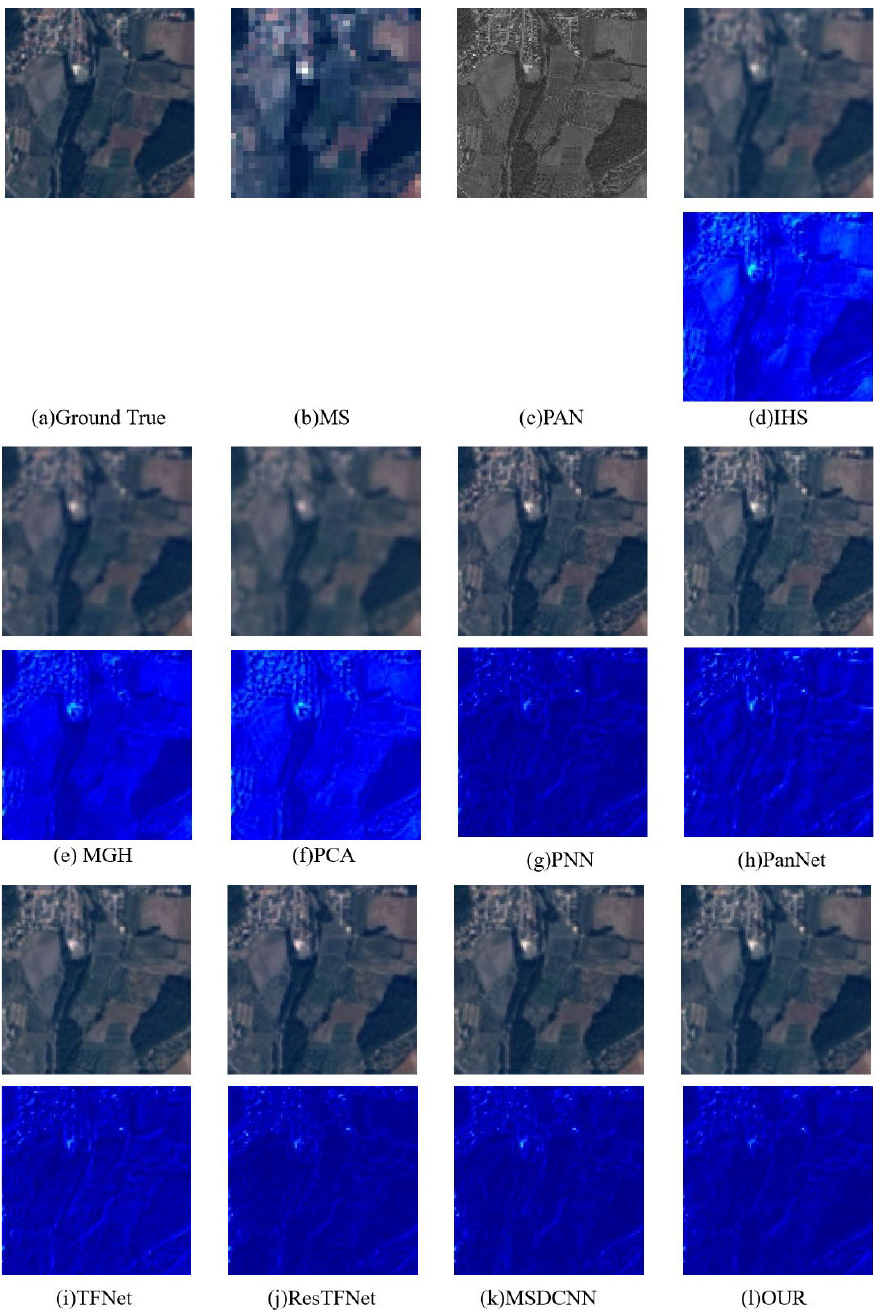
Figure 6. Pansharpening results on the SPOT6 satellite dataset. The first line is the fusion result of the SPOT6 image, and the second line is the image obtained by pseudo-coloring the differences between the fusion result of the first line and the ground truth RGB image (that is, ( a )). All images are displayed in true color (red, green, and blue being the three